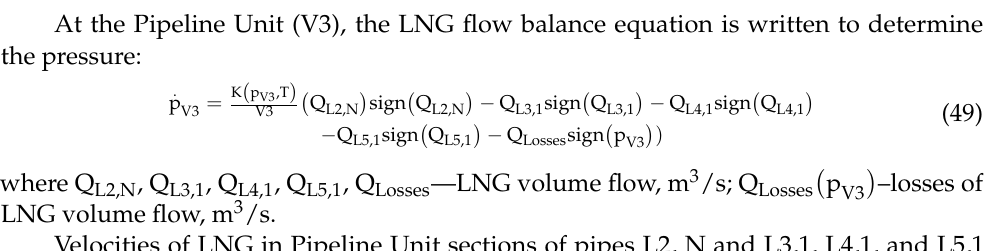
Figure 7. Pipeline Unit V3 connection with pipes (L2, L3, L4, L5). Note: see in Figure 1.